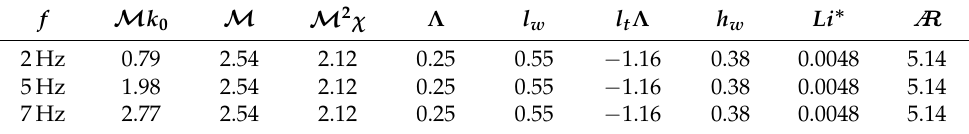
Table 1. Non-dimensional flight parameters for three flapping